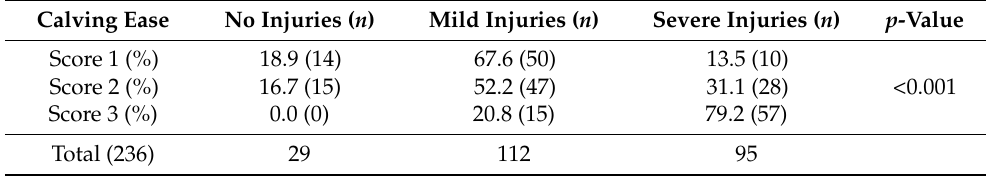
Table 3. Association between calving ease (score 1: spontaneous calving, score 2: slight assistance needed, score 3: severe assistance needed) and the occurrence of injuries of the vestibulum vaginae and/or the vagina (no injuries, mild injuries: maximum injuries of degree 1, severe injuries: injuries of degree 2, or combinations of no injuries or injuries of degree 1 with injuries of degree 2).